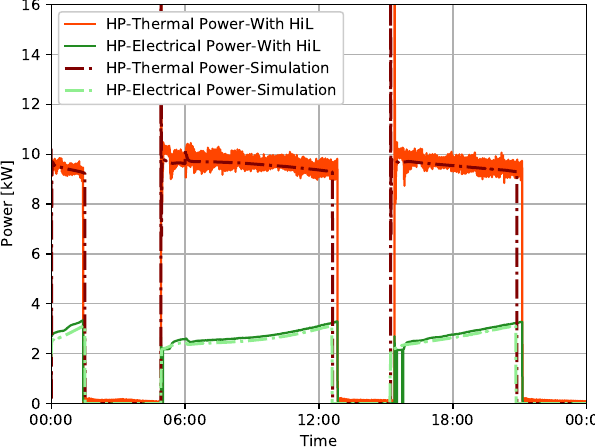
Figure 9. Heat pump thermal power and electrical power on the type